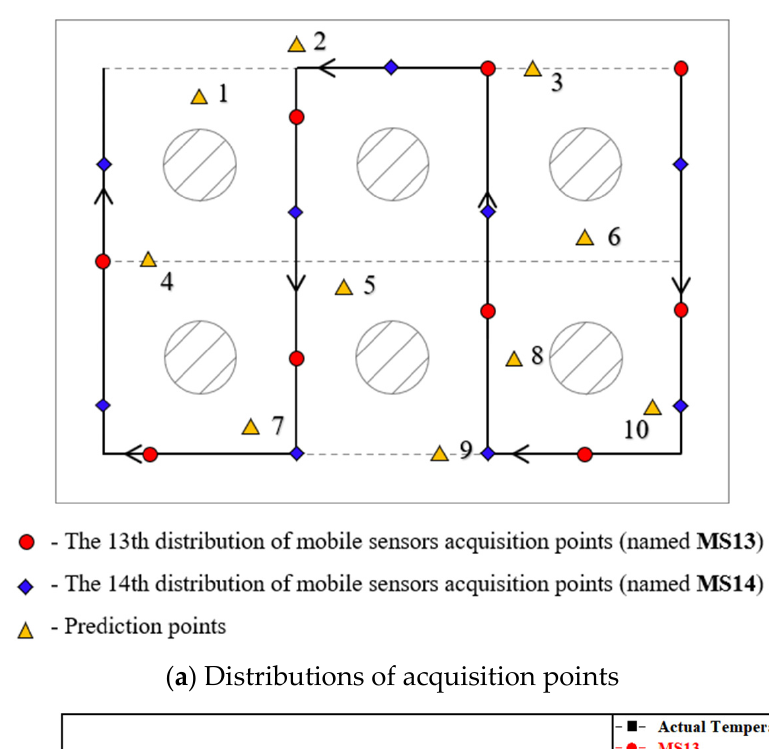
Figure 14. Prediction of mobile sensors with acquisition distance of 4.0 m.